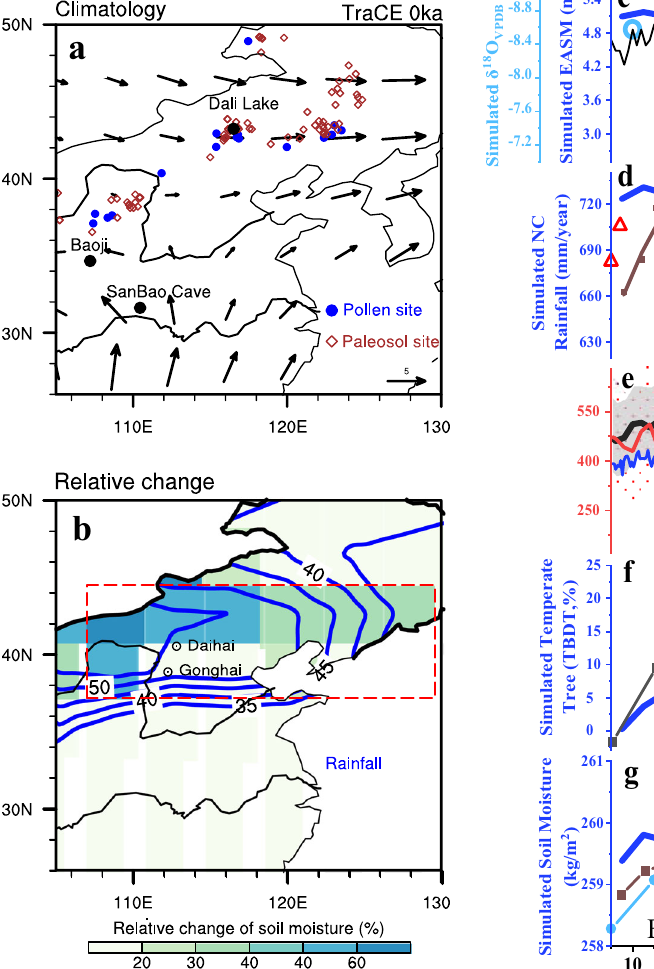
the retreating ice sheet. The retreat of the residual Laurentide ice sheet from the early to mid-Holocene enhances the EASM rainfall over NC via the circumglobal atmospheric teleconnection 34 and this impact is con fi rmed in our atmospheric model sensitivity experiments (Supplementary Fig. 6). This enhancement cancels ~2/3 of the insolation-induced rainfall decline over NC (blue in Fig. 2c, f), leaving a weak decreasing trend from the early to mid- Holocene (black in Fig. 2c, f). Relative to the insolation and ice sheet forcing, the impact of MWF on EASM via AMOC is negligible (Supplementary Fig. 7 and Supplementary Discussion).